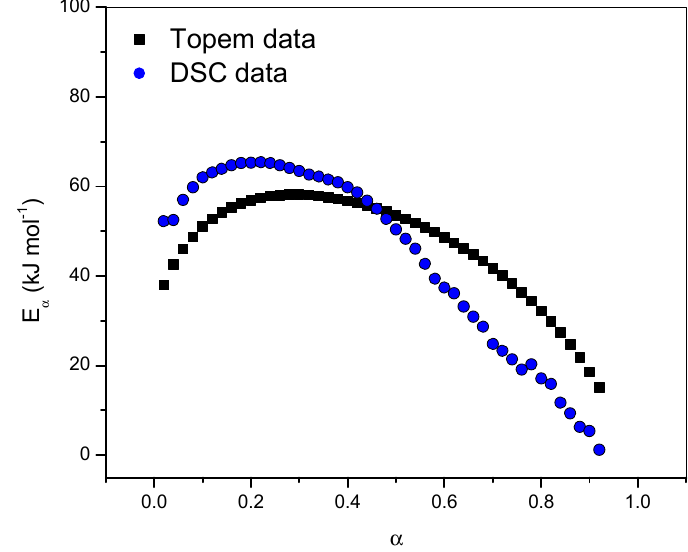
Figure 3. Evolution of the effective activation energy ( E α ) as a function of the extent of conversion ( α ) after treatment of DSC data (blue dots) and Topem ® data (black squares) obtained by isothermal curing.